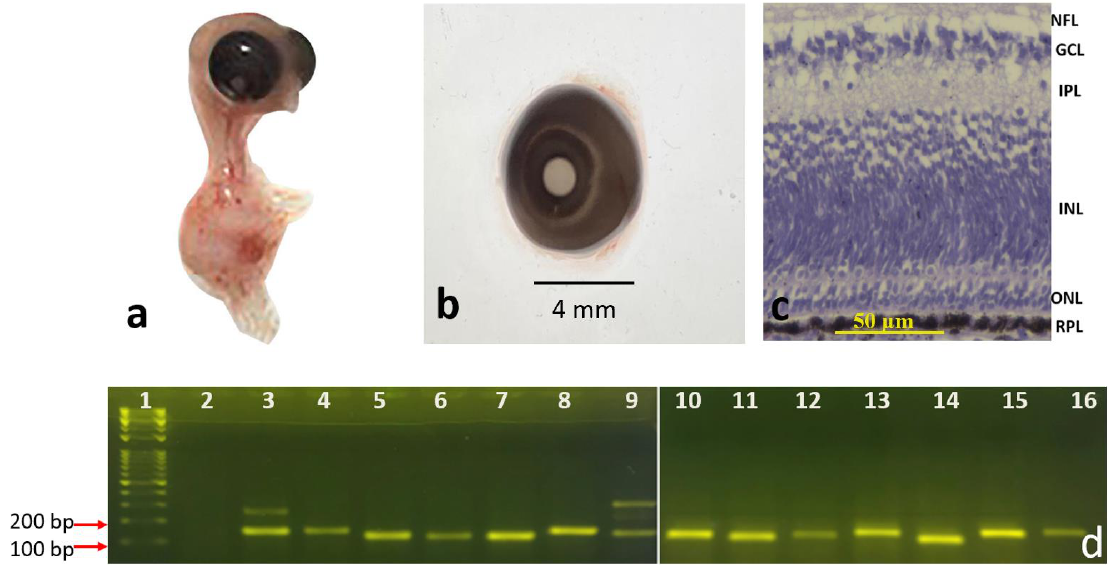
Figure 1. Eight-day chick embryos: ( a ) whole embryo, ( b ) the retrieved eye, ( c ) cross section of the